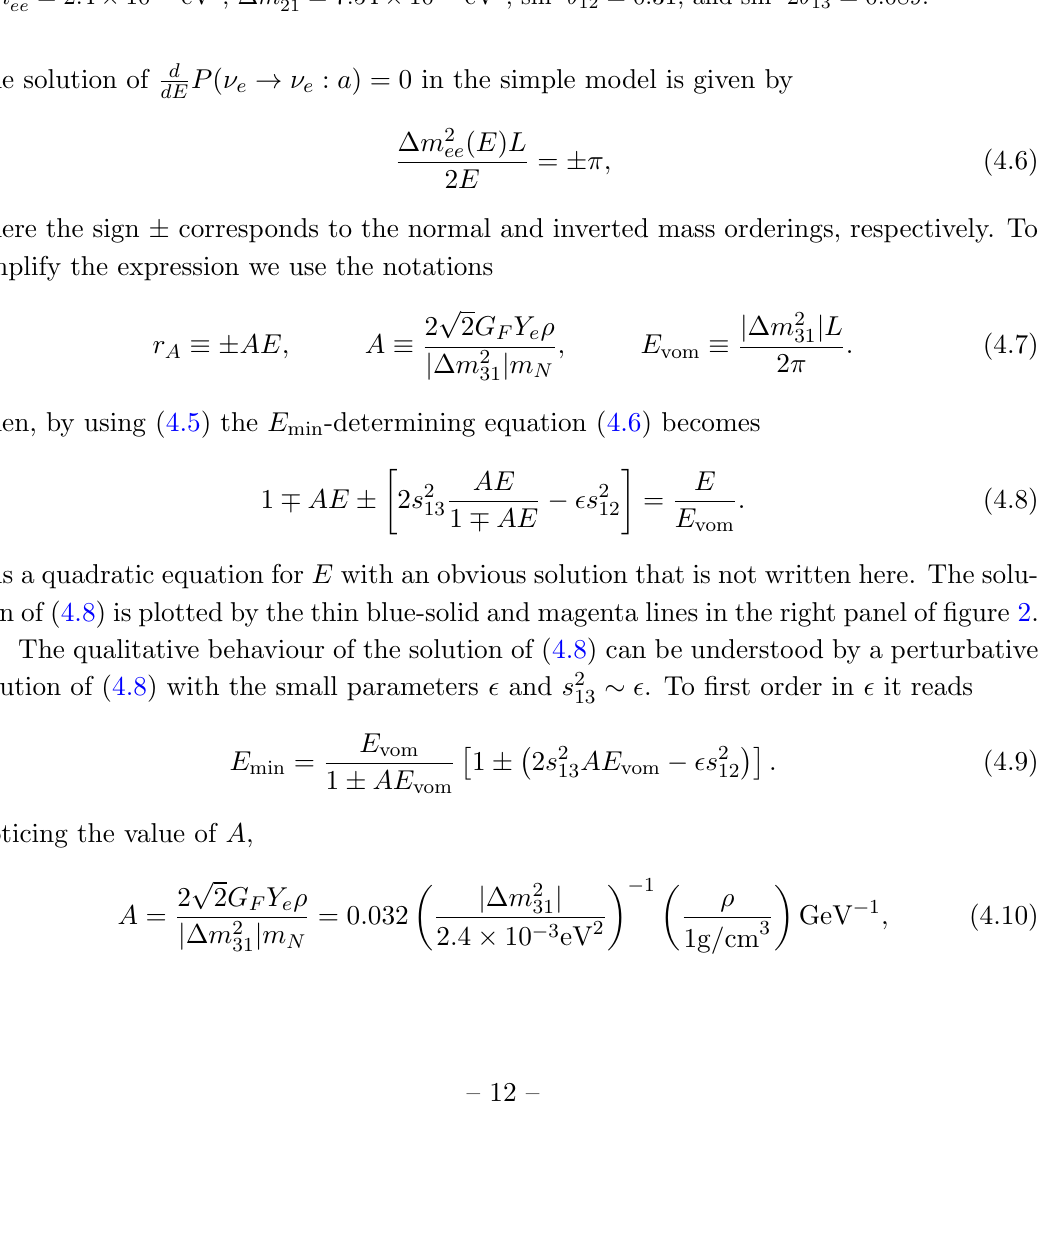
Figure 2 . The left panel: the survival probability P ( (cid:23) e ! (cid:23) e : a ) is plotted as a function of neutrino energy E obtained by numerically solving the neutrino evolution equation for various values of matter density between (cid:26) = 0 and (cid:26) = 8 g . The blue-solid and red-dashed lines are for cm 3 the normal and inverted mass orderings, respectively. The right panel: the highest-energy solution E min of the equation d P ( (cid:23) e ! (cid:23) e : a ) = 0 is plotted as a function of (cid:26) in units of g . E min dE cm 3 is with use of the same color line symbols as in the left panel. Also plotted are the solution of eq. (4.8) obtained in the simple model described in the text. The mixing parameters used are: (cid:1) m 2 = 2 : 4 (cid:2) 10 (cid:0) 3 eV 2 , (cid:1) m 2 = 7 : 54 (cid:2) 10 (cid:0) 5 eV 2 , sin 2 (cid:18) 12 = 0 : 31, and sin 2 2 (cid:18) 13 = 0 : ee 21